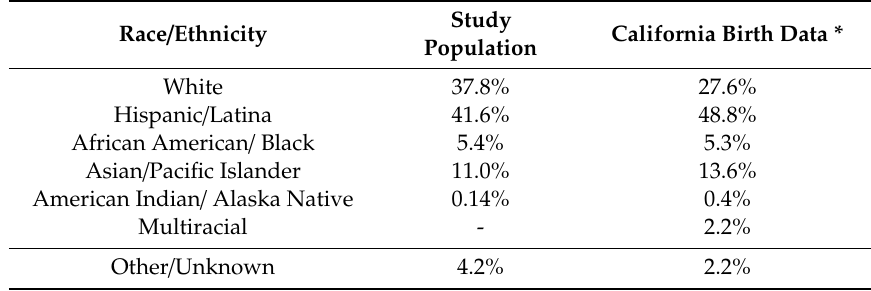
Table 1. Racial / ethnic background of the study population in comparison to population data for neonates born during the same time frame (2011–2013)